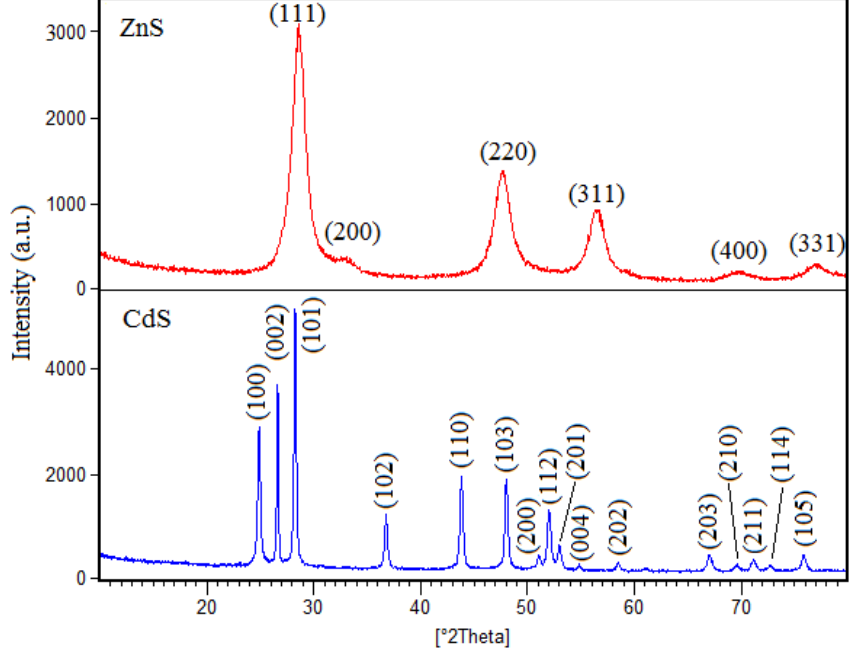
Figure 1. X-ray diffraction (XRD) pattern of the ZnS and CdS